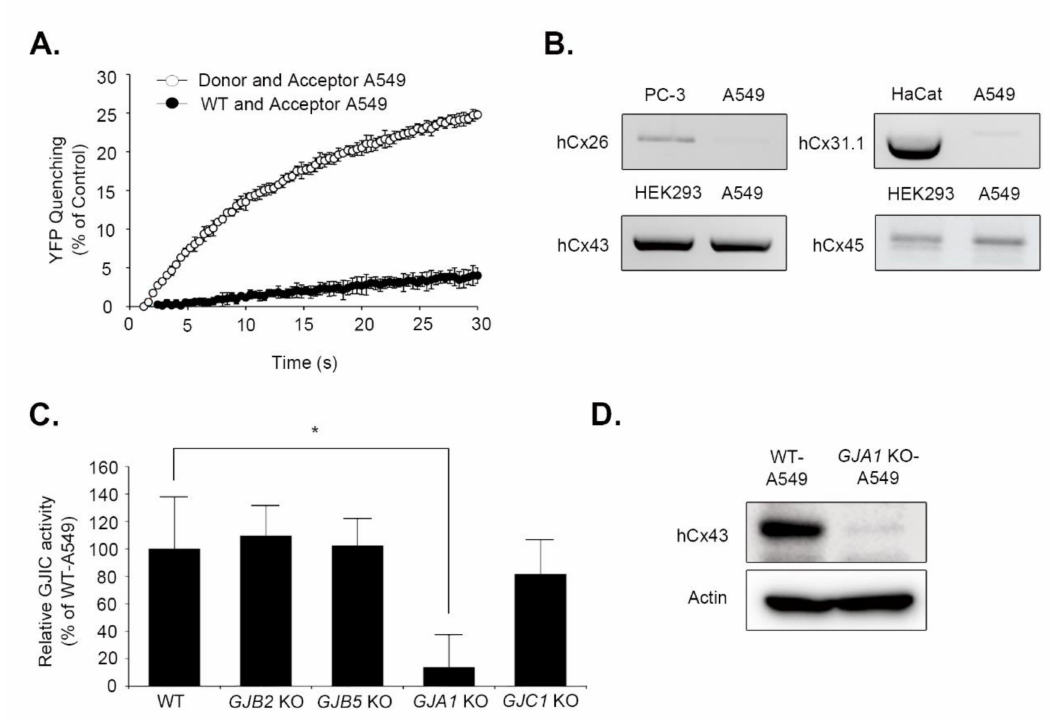
Figure 5. Identification of Cx43 as a major GJ component in A549 cells using the same